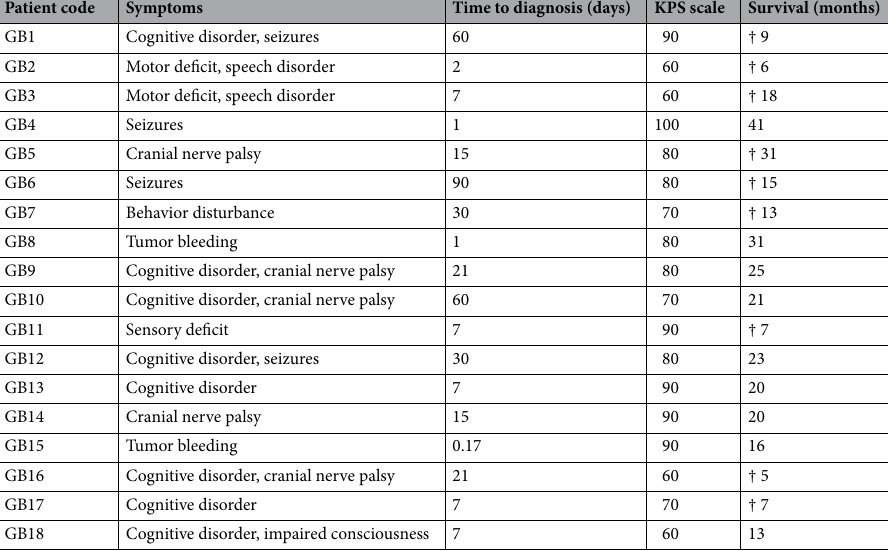
Table 2. Relevant symptoms, Karnofsky Performance Status scale and survival of high-grade glioma patients. Clinical data of individual patients concerning symptoms, time between initial symptoms to diagnosis,